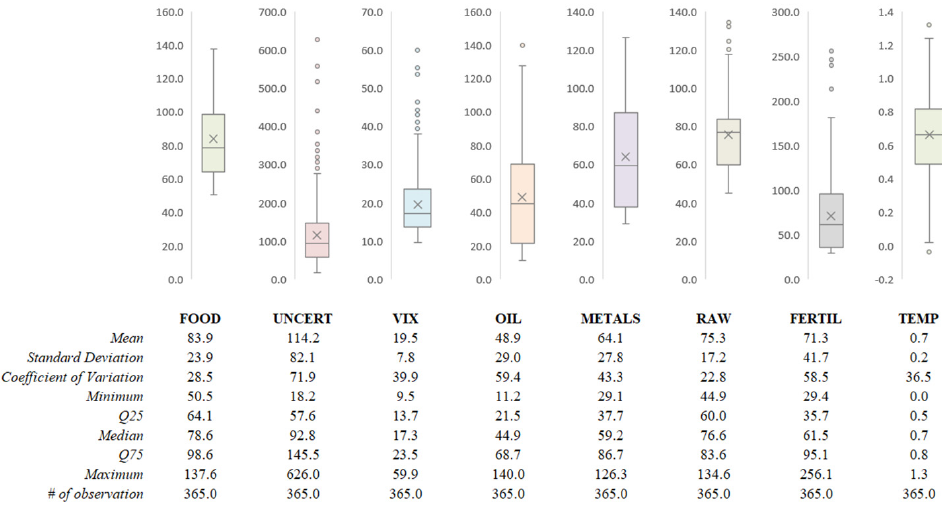
Figure 2. Descriptive statistics.